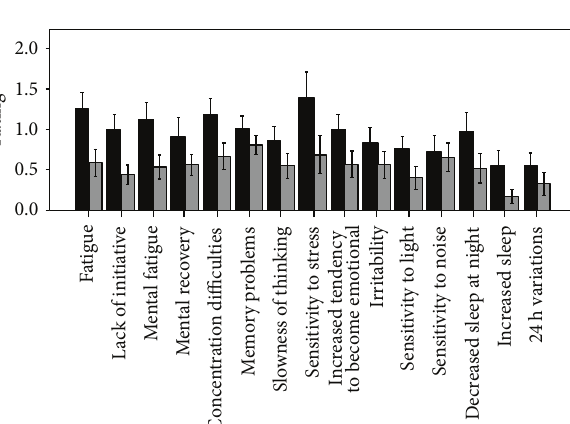
Figure 1: Bar charts showing the mean scores on the self-admin- istratedmentalfatiguescalein51patientswithCSinremission(dark grey bars) and 51 controls matched for gender, age, and educational level (light grey bars). Significant difference was found between patients and controls in all items ( 𝑃 < 0.05 ) except for sensitivity to noise ( 𝑃 = 0.7 ). Error bars represent 95% confidence